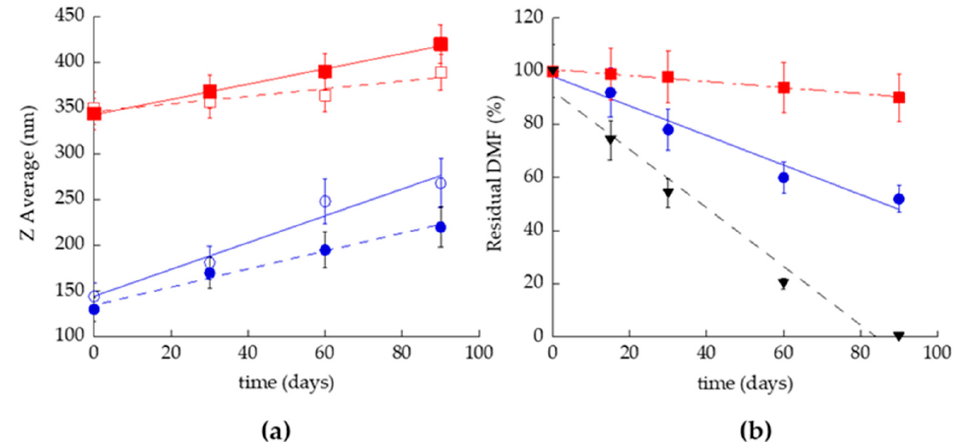
Figure 2. Effect of storage on ethosomes and transethosomes kept at 22 °C for 3 months: ( a ) Z average mean diameters measured via PCS on TET 0 . 9 (o), TET 0 . 9 -DMF ( • ), TET 2 . 7 ( □ ), and TET 2 . 7 -DMF